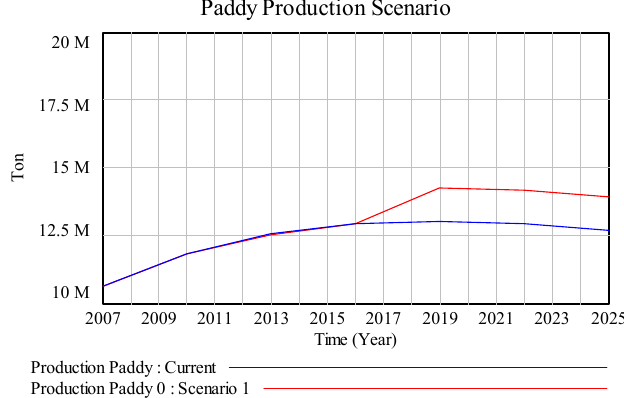
Fig.5 Result Scenario 1 Improve Agricultural Equipment and